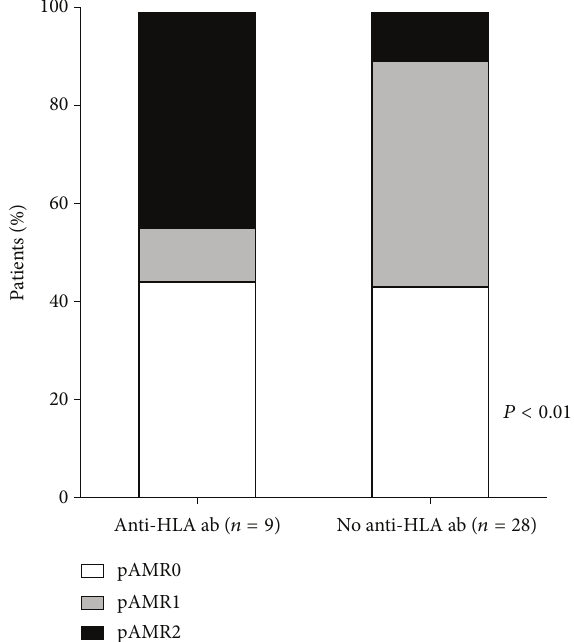
Figure 4: Anti-HLA ab and pAMR. Distribution of pAMR grades in patients with and without pretransplant HLA